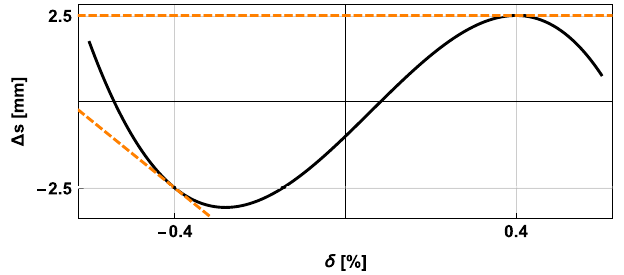
FIG. 13. Arc path length as a function of relative momentum deviation where we choose reference momentum, first, second and third order longitudinal dispersions. This allows independent control over path length and R 56 of two off-momentum beams. Example shows for two beams at δ ¼ (cid:2) 0 . 4% the path length difference is 5 mm with effective R 56 ¼ 0 mm and − 10 mm respectively, illustrated by the dashed orange lines.